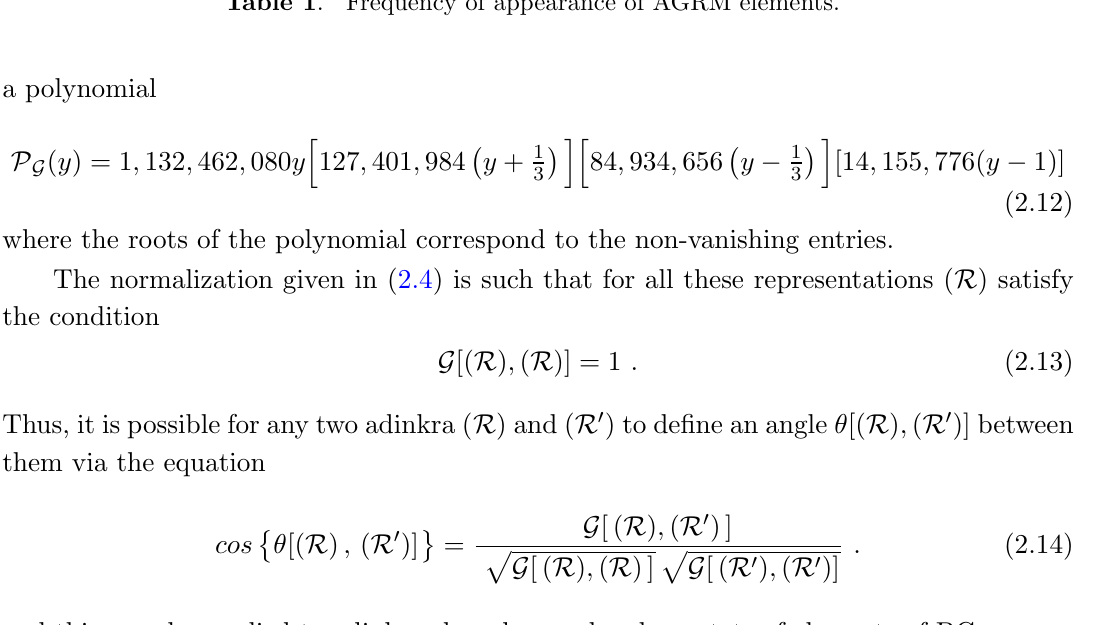
Table 1 . Frequency of appearance of AGRM